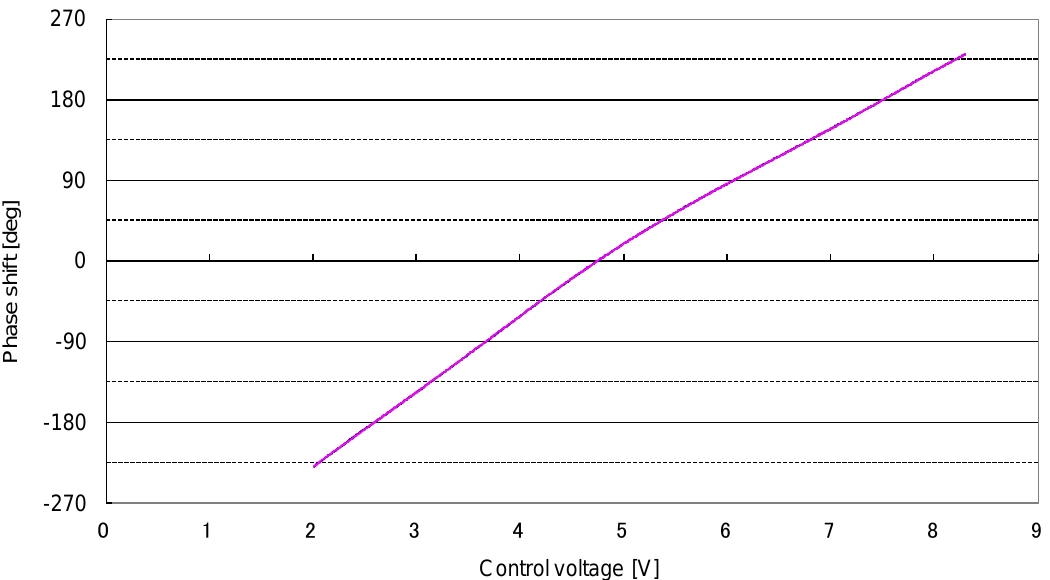
Figure 2. Calibration curve of the phase shifter. Although two curves were drawn for increasing and decreasing voltage, they cannot be separated due to less